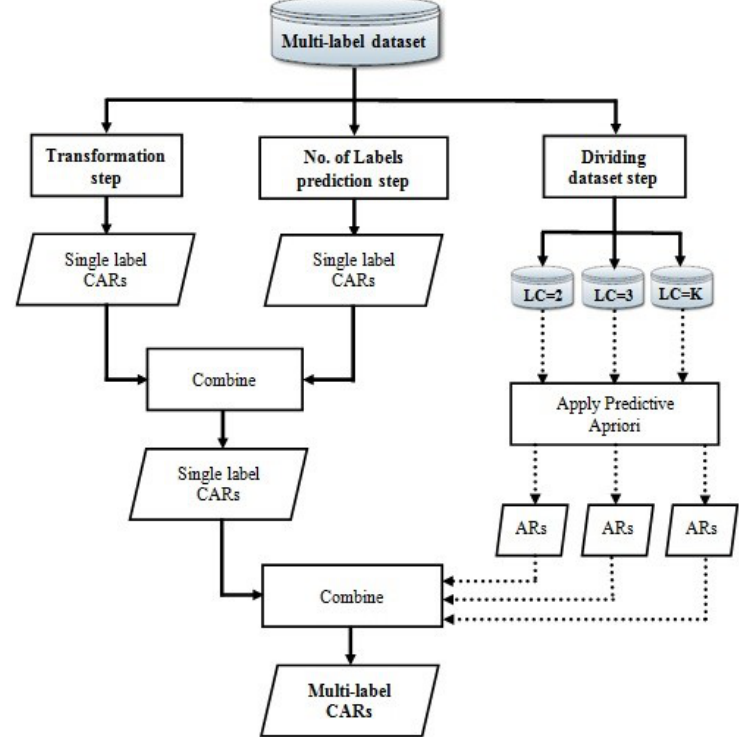
Figure 1. ML-CBA primary stages.